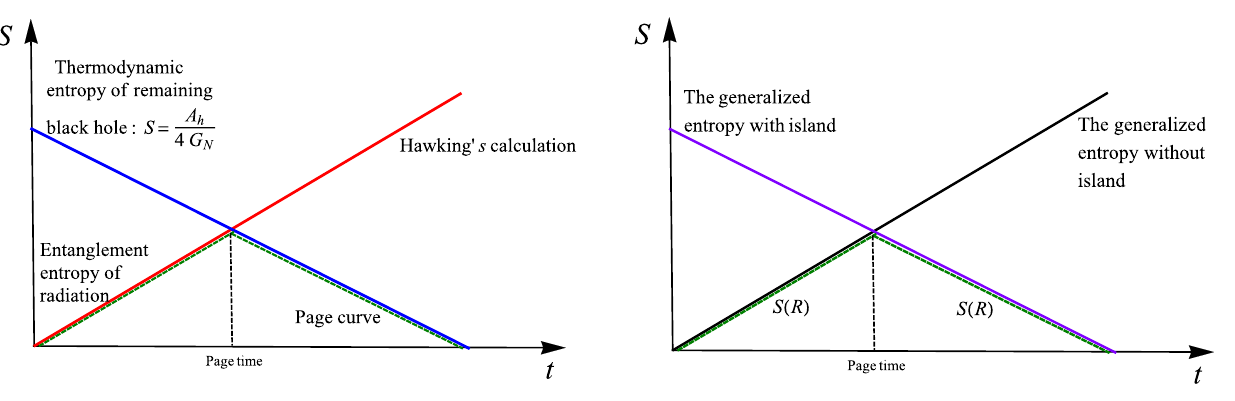
the island boundaries for D = 4 or D > 4, respectively,